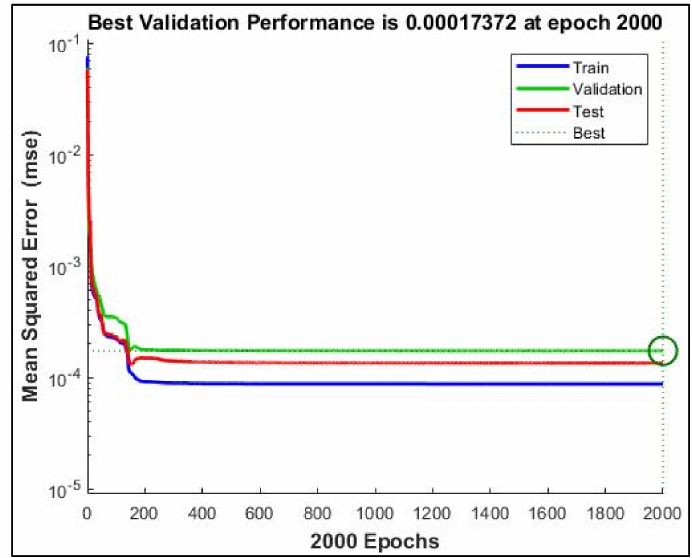
Figure 9. Validation performance of Model LID7.